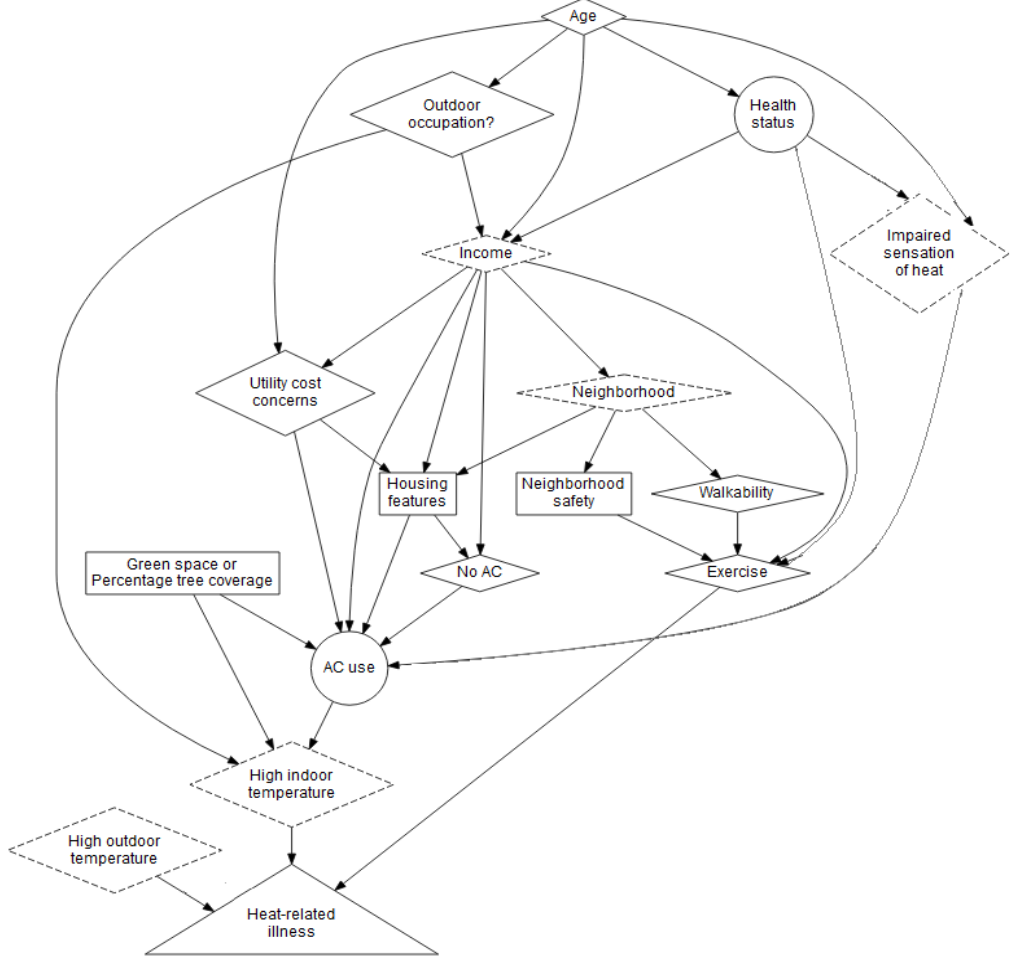
Figure 1. Directed acyclic graph (DAG) of proposed associations between and confounding of air conditioning (AC) use and heat exhaustion and self-reported health status and heat exhaustion.